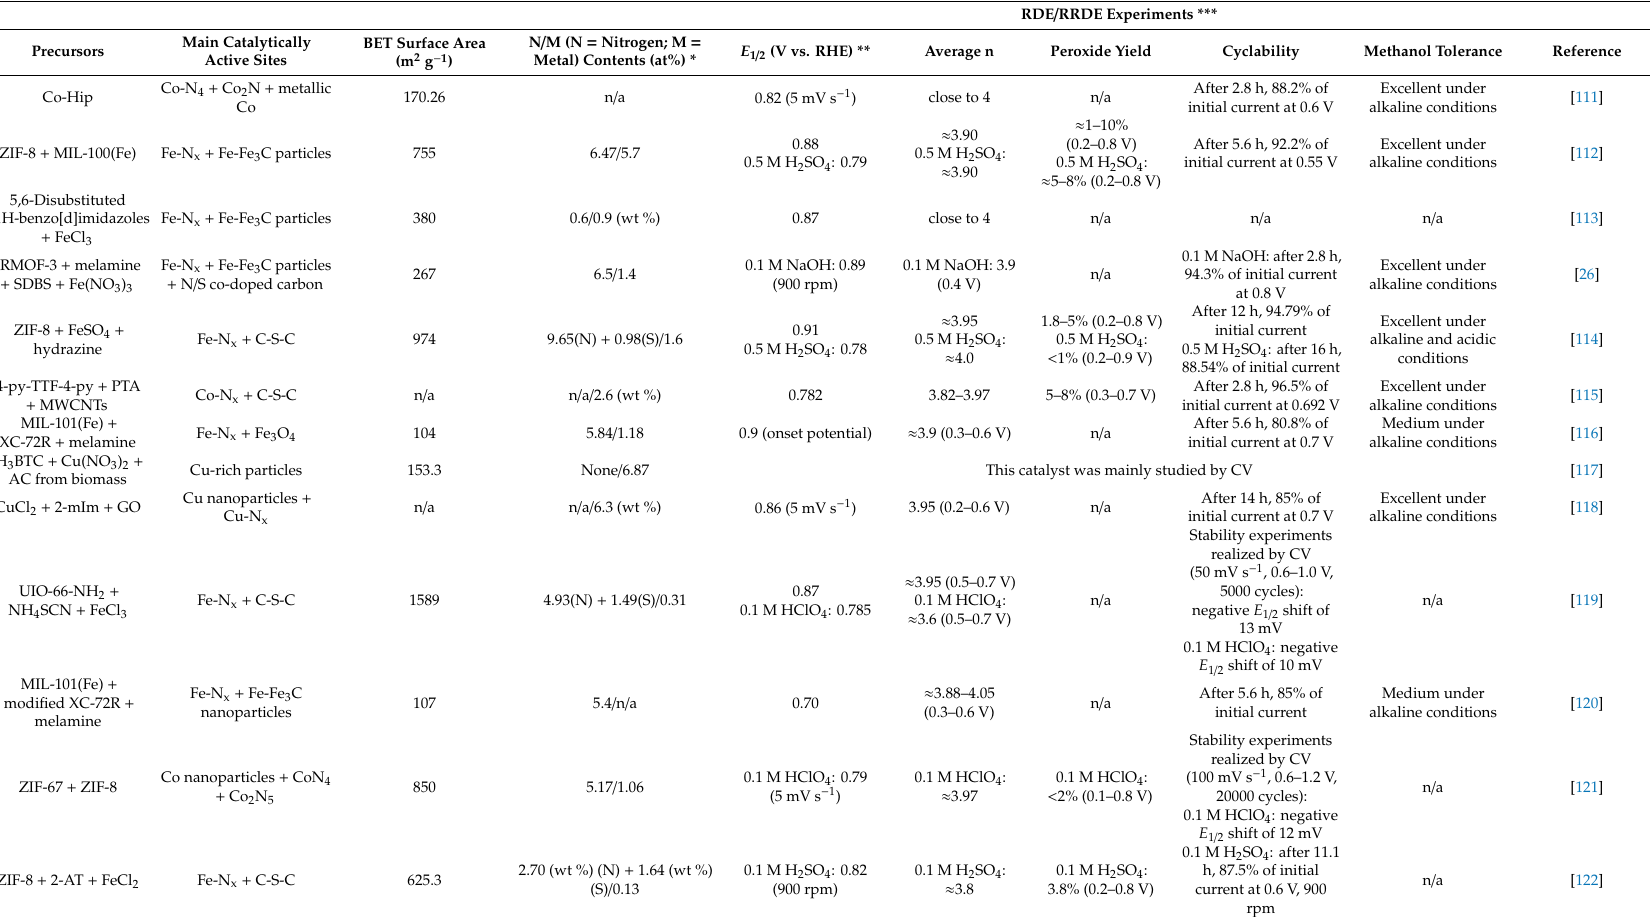
Table 6. Recent research works (2018–2020) dealing with the preparation of multi-site electrocatalysts for fuel cells with a focus on ORR activity. Examples in acidic and alkaline media are provided, and major physicochemical properties and electrochemical performances realized using rotating electrodes are